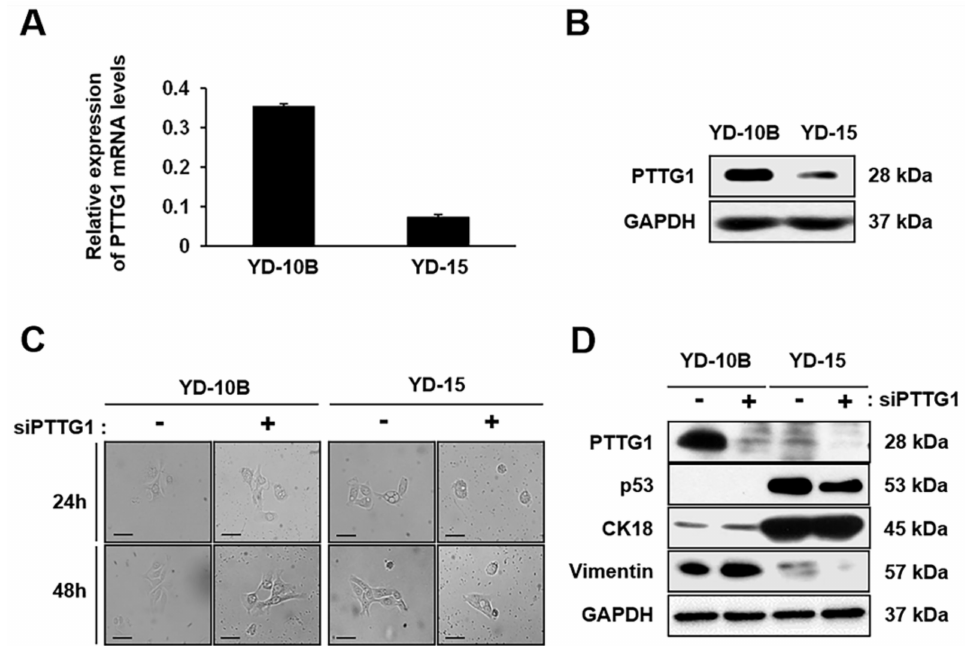
Figure 1. Expression of PTTG1 in oral SCCcell lines. ( A ) The mRNA and ( B ) protein expres- sion of PTTG1 in YD-10B and YD-15 cell lines were analyzed by qRT-PCR and Western blots. ( C )Morphologies of the YD-10B and YD-15 cell lines after 200 nM siPTTG1 treatment for 24 or 48 h. Magnification, × 400; scale bar = 50 µ m. ( D ) The expression of PTTG1, p53, CK18, and vimentin in YD-10B and YD-15 cell lines analyzed by Western blots after 200 nM siPTTG1 treatment for 24 h. GAPDH was used as an internal control. CK18, cytokeratin